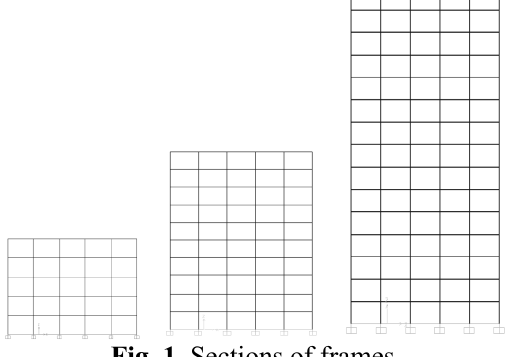
Fig. 1. Sections of